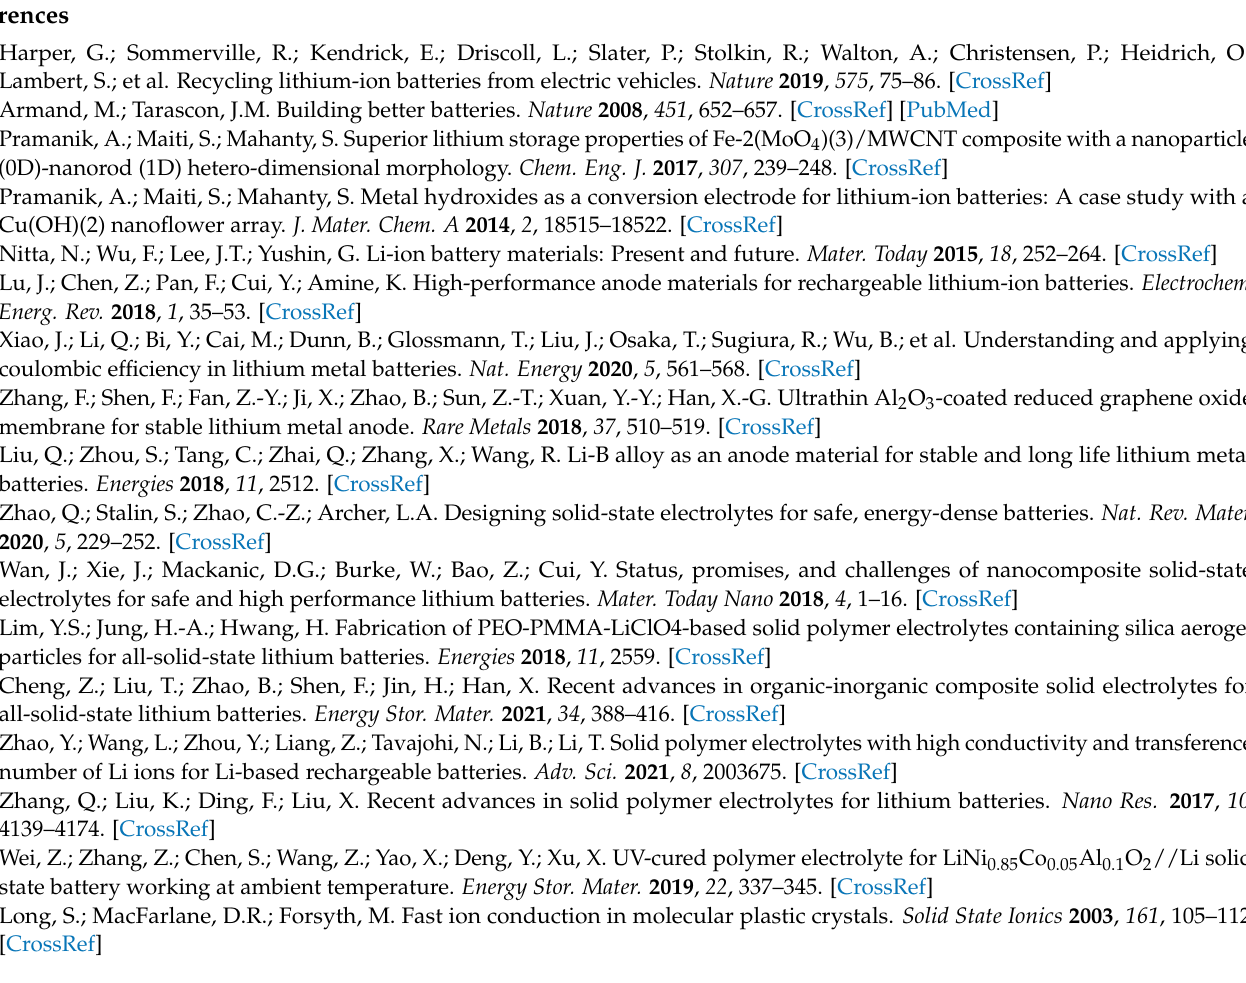
film, Figure S3: SEM image of cross section of SPCE film, Figure S4: Photographs of SPCE film, Figure S5: Schematic diagram of the structure of SN doped with LiTFSI salt, Figure S6: LSV curve with SS|SPCE|Li